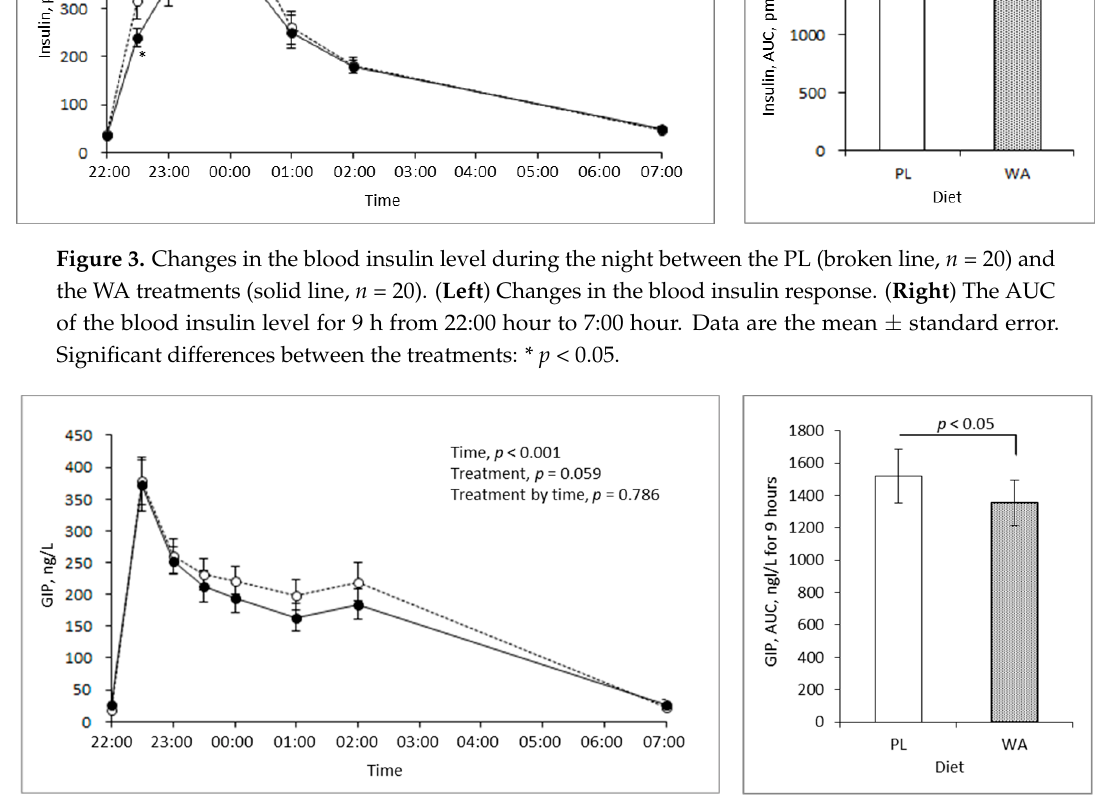
Figure 3. Changes in the blood insulin level during the night between the PL (broken line, n = 20) and the WA treatments (solid line, n = 20). ( Left ) Changes in the blood insulin response. ( Right ) The AUC of the blood insulin level for 9 hours from 22:00 hour to 7:00 hour. Data are the mean ± standard error. Significant differences between the treatments: * p < 0.05.